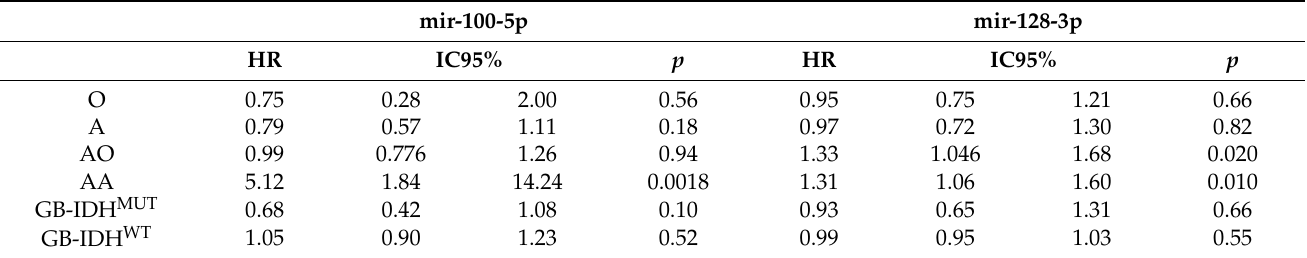
Table 6. Value of mir-100-5p or mir-128-3p within WHO 2016 classes for PFS.